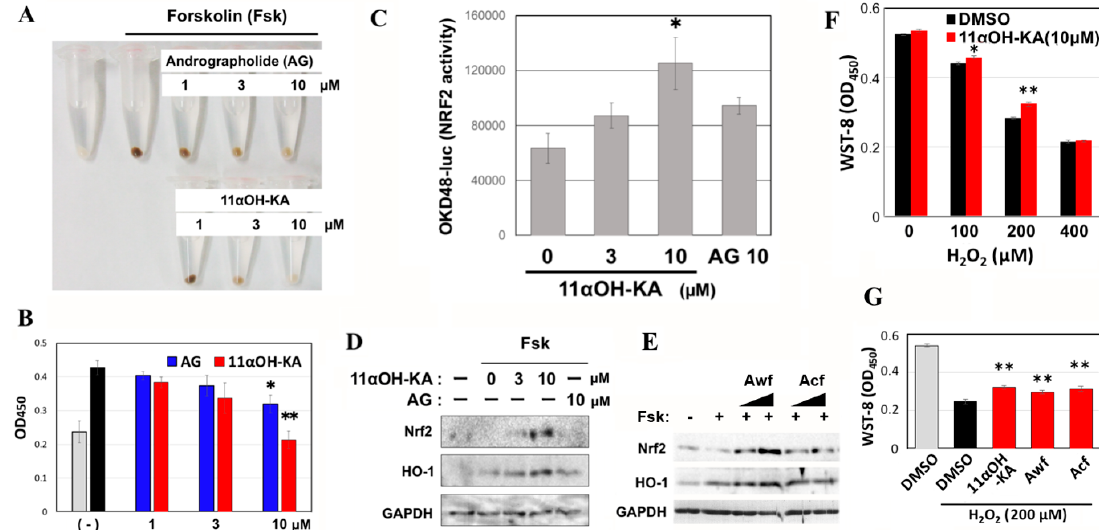
Figure 6. 11 α OH-KA upregulates Nrf2 pathways. B16F10 cells were treated with the indicated concentrations of 11 α OH-KA or andrographolide (AG) for 24 h. The cells were recovered into sample tubes, and melanin contents were evaluated by photos ( A ) and optical density after lysis with NaOH ( B ). ( C ) B16F10 cells that had been transformed with the Nrf2 reporter (OKD48-luc) were treated with 11 α OH-KA or AG for 24 h. Means and S.D. are shown ( n = 3). *: p < 0.05. ( D ) The cells were lysed with SDS sample bu ff er without the reducing agent mercaptoethanol and used for Western blot analyses. ( E ) Awf (400 or 1200 µ g mL − 1 ) and Acf (300 or 900 µ g mL − 1 ) were used as stimulants. ( F ) B16F10 cells that had been precultured with or without 10 µ M of 11 α OH-KA for 24 h were treated with H 2 O 2 for a further 24 h. Cell variability was examined by the Cell Counting kit (WST-8). ( n = 4) ** p < 0.01. ( G ) The same experiments were performed with 11 α OH-KA (10 µ M), Awf (1260 µ g mL − 1 ), and Acf : (888 µ g mL − 1 ) in the presence of 200 µ M H 2 O 2 . Gray and black bars indicate without H 2 O 2 treatment and with only H 2 O 2 treatment,